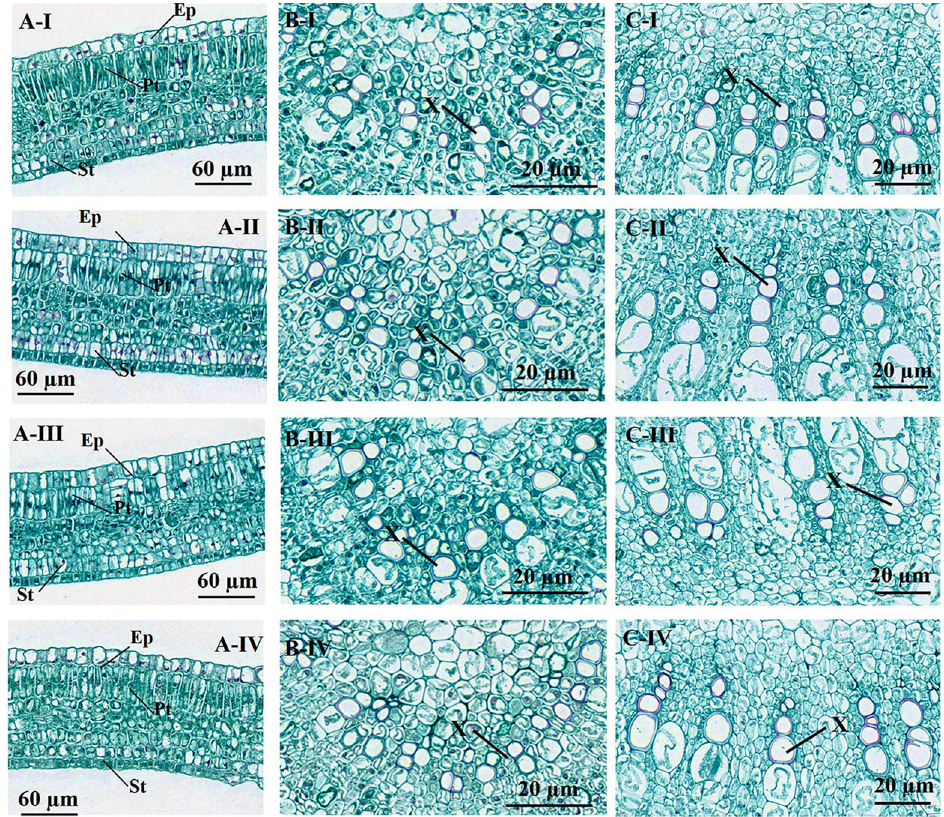
Figure 3. Mesophyll cell, leaf vein, petiole structure of red T. sinensis buds during storage. ( A-I ): Mesophyll cell structure of red T. sinensis budsstored for 0 d; ( A-II ): Mesophyll cell structure of red T. sinensis buds stored for 1 d; ( A-III ): Mesophyll cell structure of red T. sinensis buds stored for 2 d; ( A-IV ): Mesophyll cell structure of red T. sinensis buds stored for 3 d; ( B-I ): Leaf vein structure of red T. sinensis budsstored for 0 d; ( B-II ): Leaf vein structure of red T. sinensis budsstored for 1 d; ( B-III ): Leaf vein structure of red T. sinensis budsstored for 2 d; ( B-IV ): Leaf vein structure of red T. sinensis budsstored for 3 d; ( C-I ): Petiole structure of red T. sinensis budsstored for 0 d; ( C-II ): Petiole structure of red T. sinensis budsstored for 1 d; ( C-III ): Petiole structure of red T. sinensis budsstored for 2 d; ( C-IV ): Petiole structure of red T. sinensis budsstored for 3 d. Epidermis (Ep), palisade tissue (Pt), sponge tissue (St), xylem (X) were marked in figure.